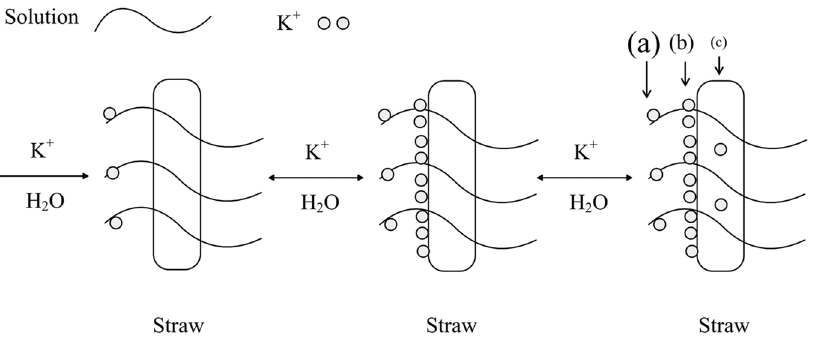
Figure 7. Schematic of the adsorption process of potassium (K + ) on the rice straw residue surface. (a) K + retained on the straw in the form of an aqueous solution absorbed by residue; (b) K + adsorbed via electrostatic interaction; and (c) K + fixed on the residue surface by chemically interfacial adsorption. The size of the three letters indicates the amount of K + reserved on the residue by the corresponding process.